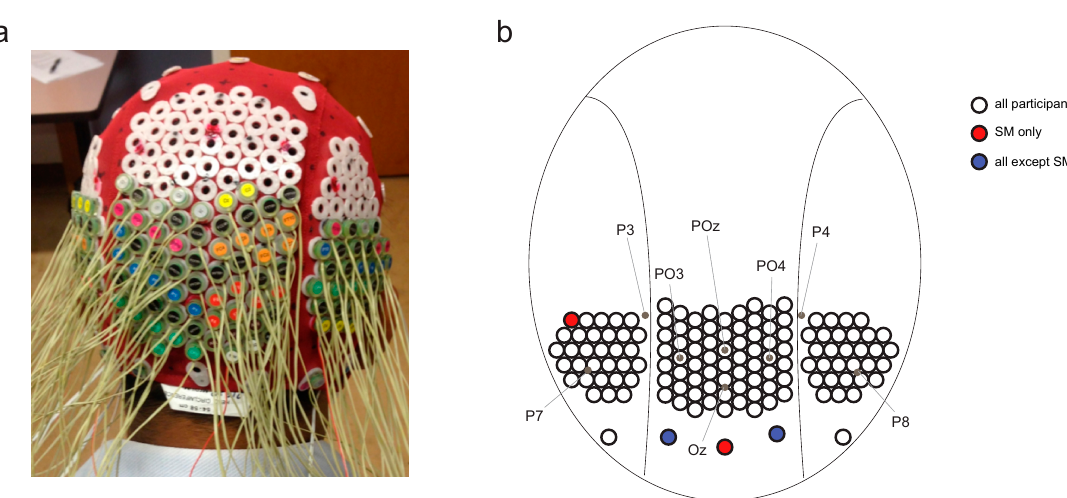
Figure 2. Head cap configuration. A ) Modified electroencephalography (EEG) head cap with high-density electrode configuration. B ) Map of electrode configuration on the back of the head, showing approximate locations of electrodes from the 10–20 standard configuration.